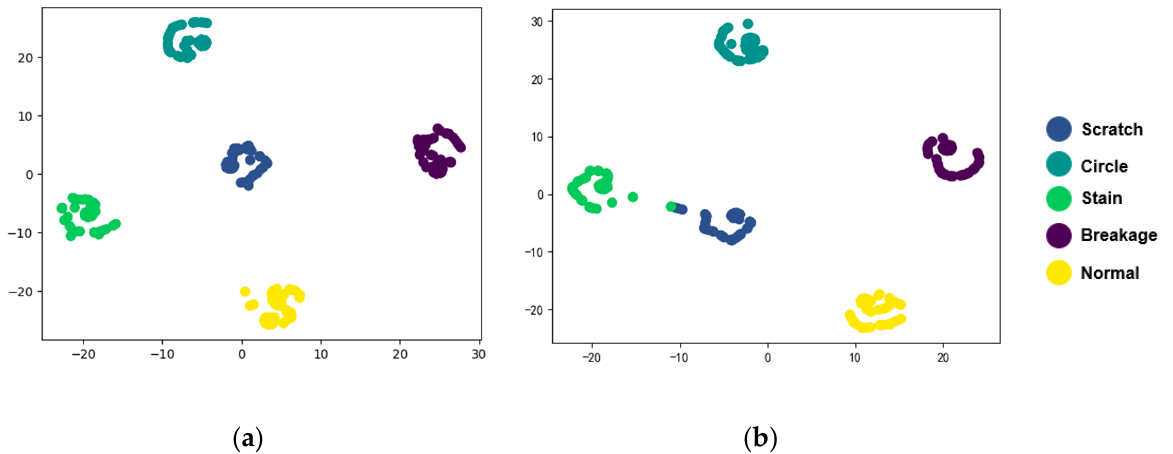
Figure 10. A 2D feature visualization using the t-SNE algorithm for the last layer of the network: ( a )